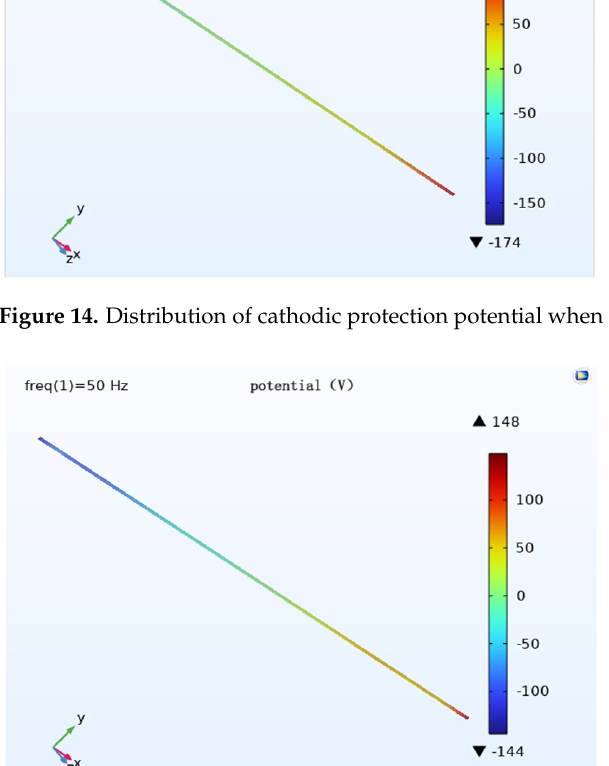
Figure 16. The effect law of parallel distance on the cathodic protection potential of the pipeline. 6.4. Effect of Transmission Line Height to the Ground on Pipeline Cathodic Protection Potential In order to study the effect of transmission line height on cathodic protection poten- tial, the burial depth is 2 m, the voltage level of the transmission line is 1000 kV, the par- allel spacing is 0 m, and the wire arrangement is horizontal, as in the initial condition, and the pipeline cathodic protection potential distribution is simulated when the wire height is 18 m, 28 m and 38 m, respectively. The potential size is different when the distance to the ground is different but the potential distribution law is roughly the same. When the transmission line height is 18 m, the maximum potential of the pipeline is about 230 V; when the transmission line height is 28 m, the maximum potential of the pipeline is about 199 V; when the transmission line height is 38 m, the maximum potential of the pipeline is about 160 V.